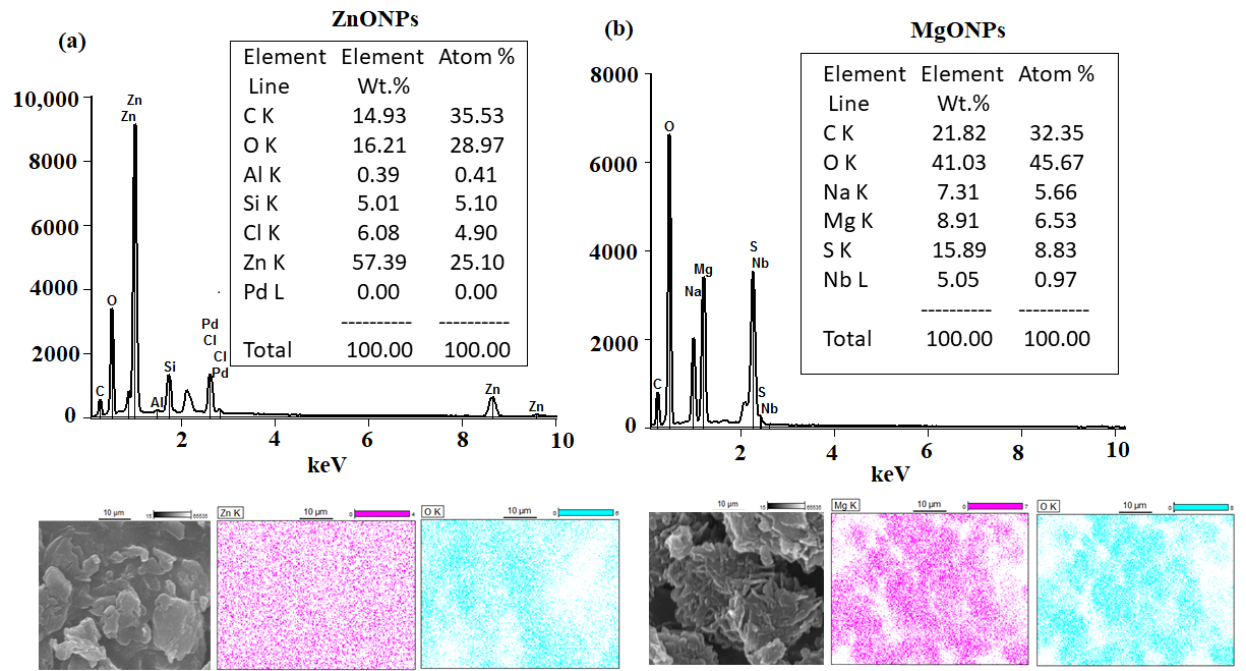
Figure 6. The SEM images of the ( a , b ) ZnONPs and ( c , d ) MgONPs measured at different magnifications.